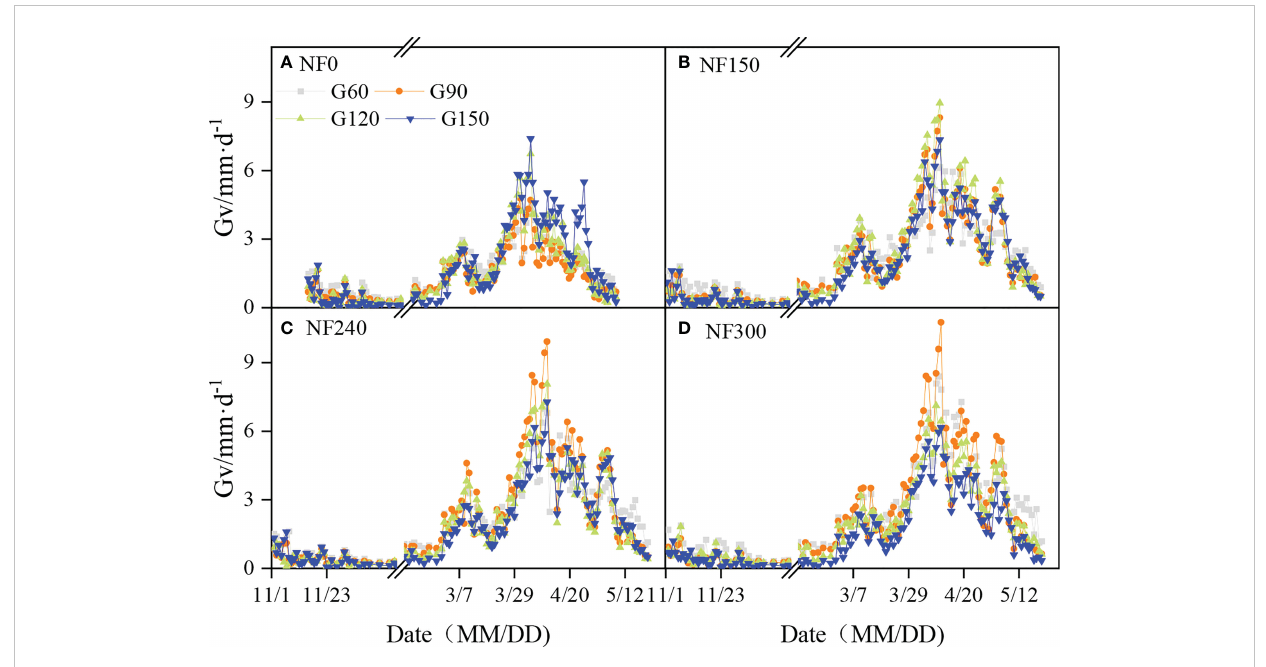
FIGURE 4 Daily groundwater consumption velocity of winter wheat. MM/DD means month and